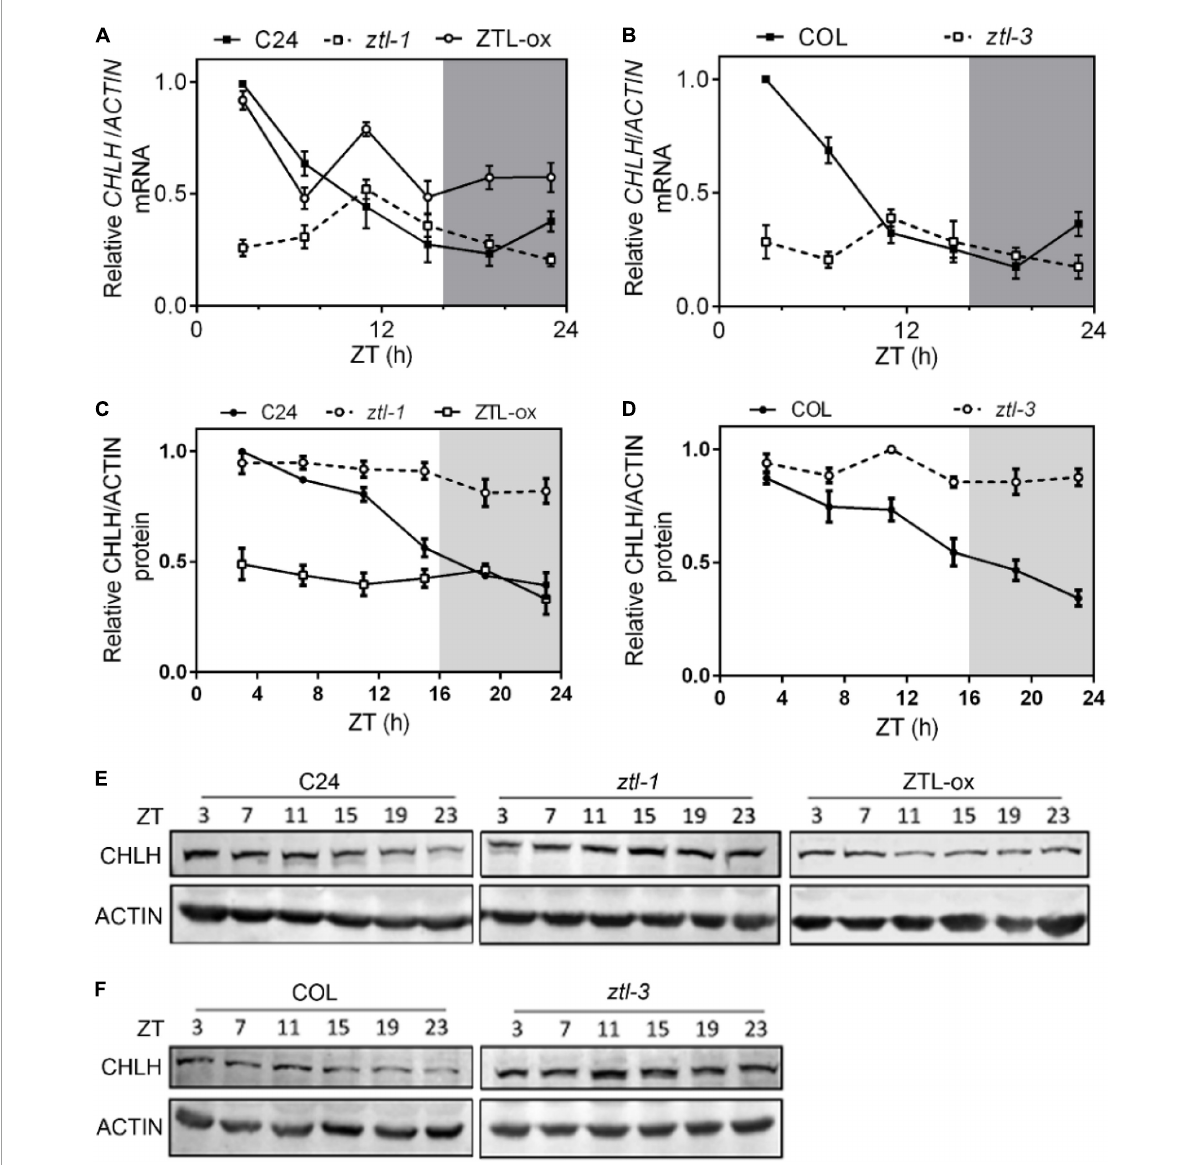
FIGURE3 Comparisons of CHLH protein and mRNA abundance in ZTL miss-expressing plants. (A–D) CHLH mRNA (A,B) and protein (C,D) expression analysis in C24, ztl-1 , ZTL-ox, Col and ztl-3 plants. Seedlings were entrained under long day cycles for 2 weeks, and samples were collected at the indicated Zeitgeber Time (ZT). Means ± SE of four independent experiments are represented relative to the maximum value and normalized to ACTIN expression. (E,F) Comparisons of relative CHLH protein abundance in C24, ztl-1 , ZTL-ox (E) , Col and ztl-3 (F) plants by western